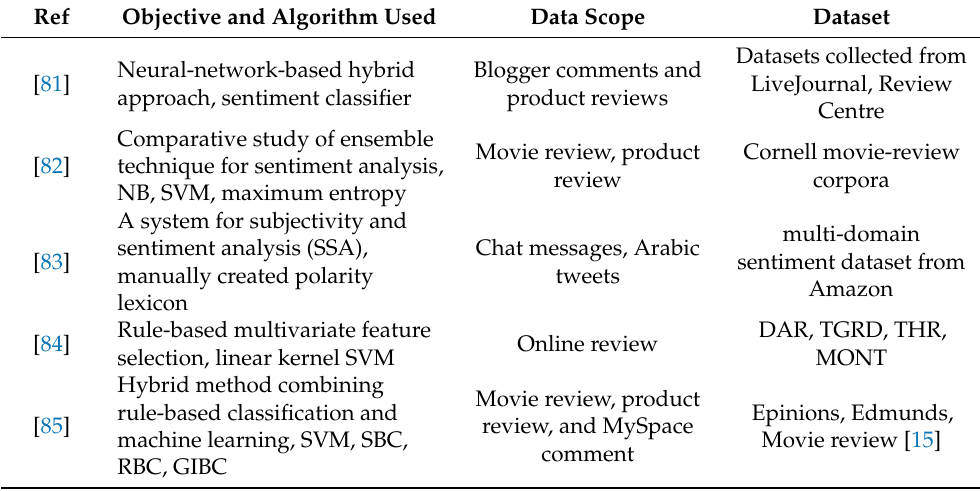
Table 6. The list of hybrid-based approaches proposed for sentiment